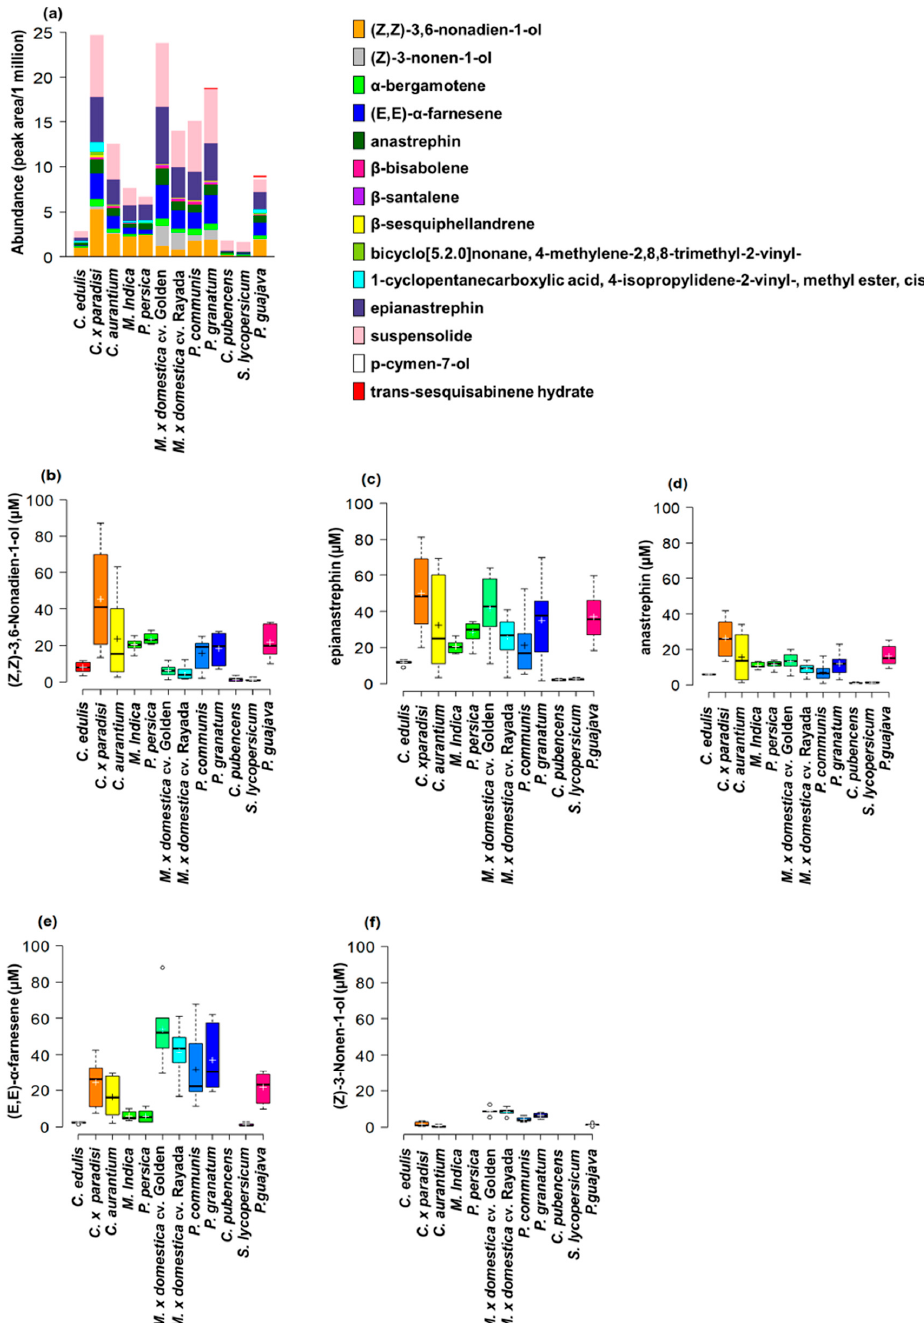
Figure 1. Chemical compounds identified in the effluvia (scent bouquets) of sexually-mature calling A. ludens males developed as larvae in different hosts. ( a ) The abundance (peak area/one million) of the 14 compounds tentatively identified by comparing mass spectra registered in the National Institute of Standards and Technology (NIST) library or confirmed with authentic standards. Note that the color bars of some compounds are extremely narrow and almost undetectable because such compounds were identified in relatively small abundances (the exact abundances of the compounds identified are available in Table S2). ( b – f ) Boxplots of the concentration of the compounds confirmed with authentic standards; the box shows the interquartile range and the horizontal line in each box the median, the whiskers indicate the minimum and maximum values, open circles indicate outliers, and the cross inside the box the mean. “Golden” used as abbreviation for ‘Golden Delicious’ in the case of M. × domestica